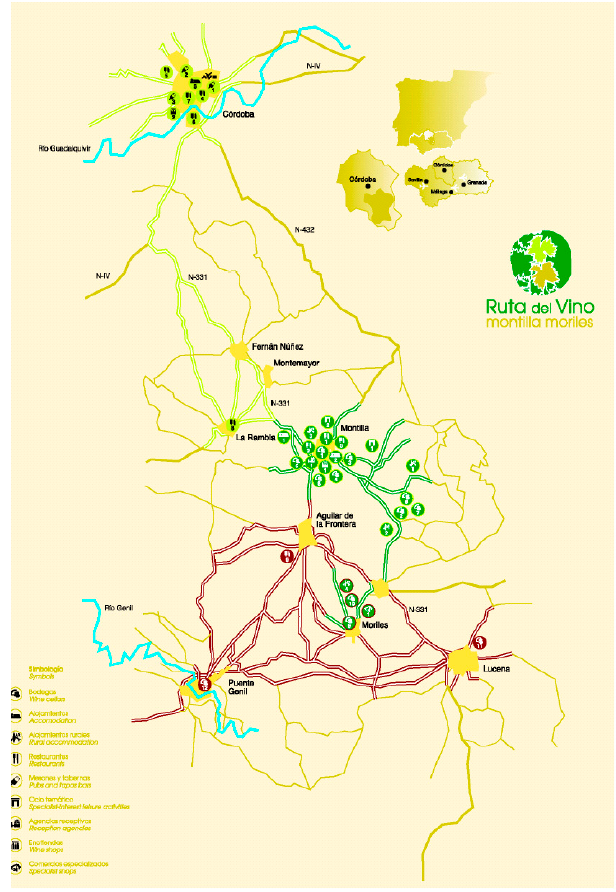
Figure 5. “Montilla-Moriles” wine route. Source